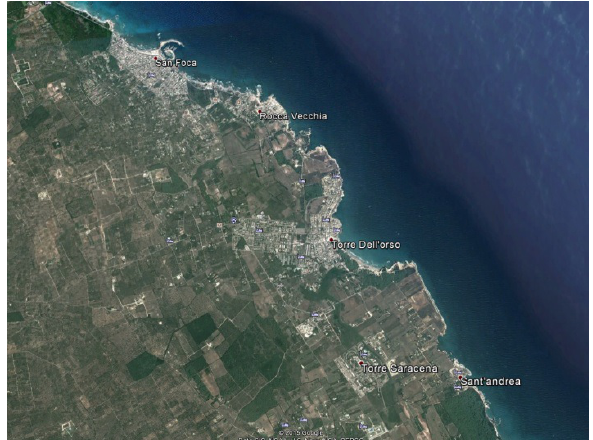
Figure 1: The study area (Google Earth)